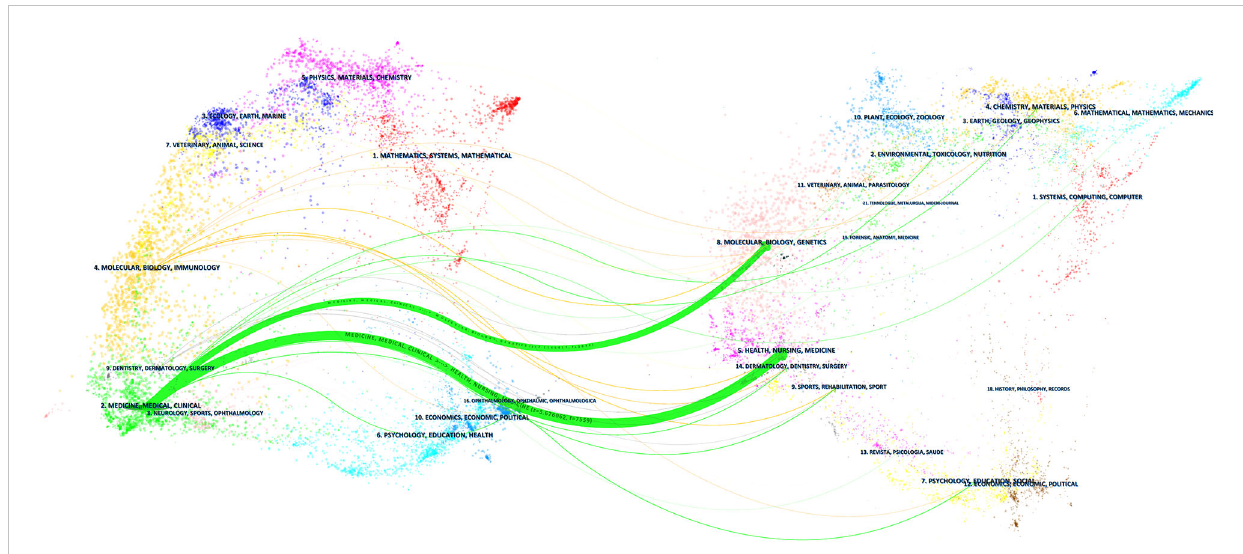
FIGURE 5 The dual-map overlay of journals publishing studies on AIP. Citing journals are on the left, cited journals are on the right, and lines represent the citation